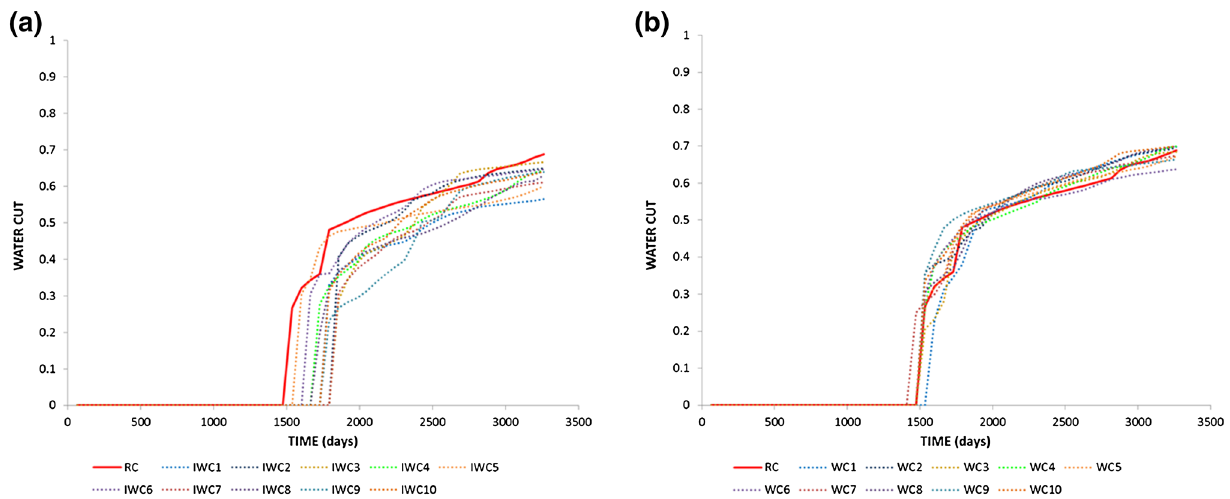
Fig. 16 a Initial water cut profiles for 10 cases (dotted lines). b Water cut profiles for 10 matched cases (dotted lines). The reference water cut is the solid red